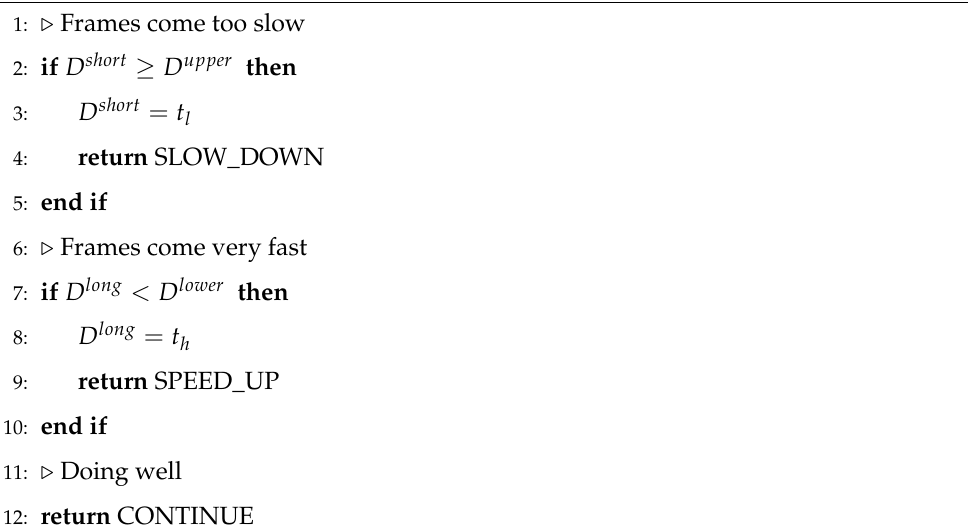
Algorithm 1 EVeREst bitrate